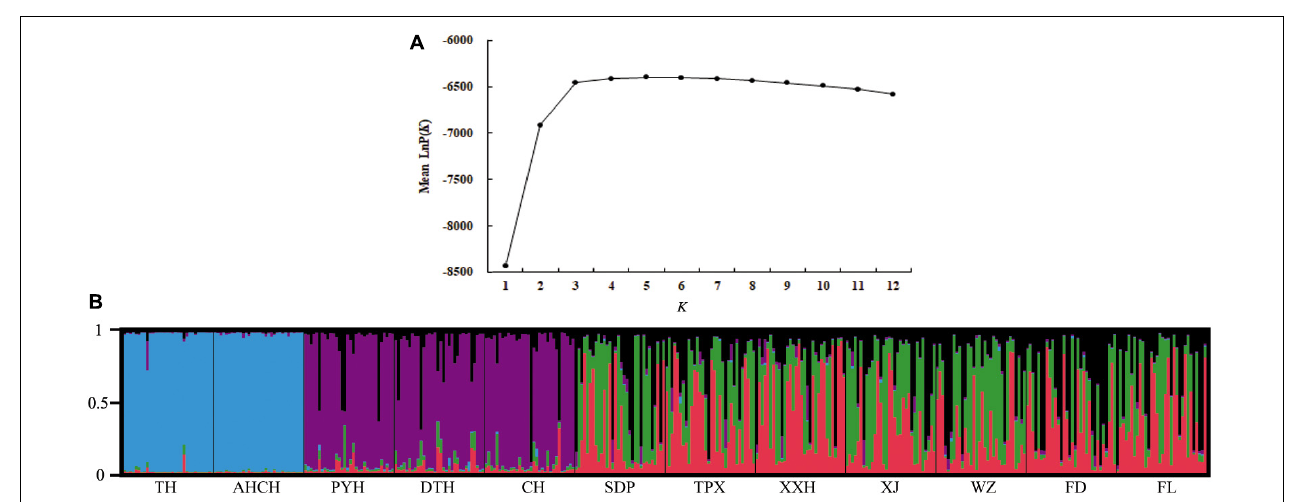
FIGURE 4 | STRUCTURE analysis based on genotypes at eight microsatellite loci from 384 unique C. brachygnathus individuals sampled from 12 different sites in the Yangtze River Basin, China. (A) Estimation of mean log probability LnP(K) for K = 1–12 using Structure Harvester. K = 5 is shown as the optimal value. (B) Proportions of each individual assigned to each inferred cluster. The five colors indicate five inferred distinct genetic clusters. Sampling sites of individuals are shown at the bottom.